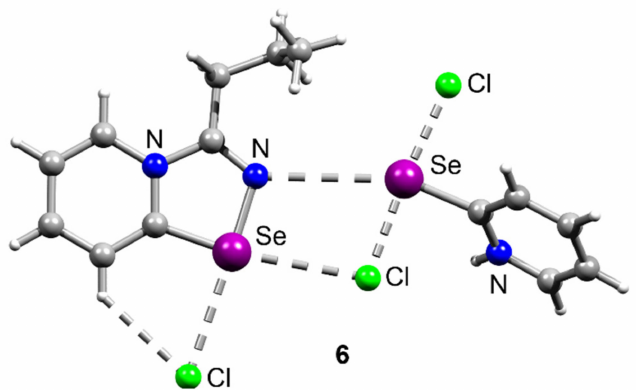
Figure 3. Ball-and-stick representation of the crystal structure of 6 , demonstrating attractive Se ··· N, Se ··· Cl, and H ··· Cl interactions. Grey and light-grey spheres represent carbon and hydrogen, respectively.